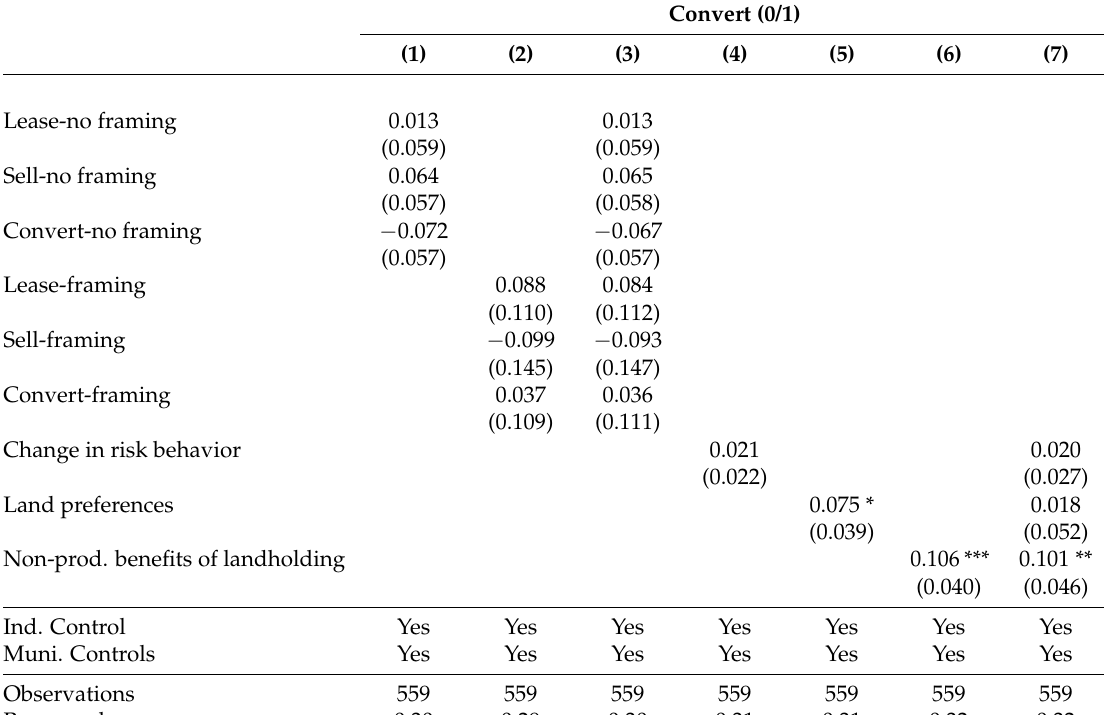
Table 8. Predictors of pasture to crop